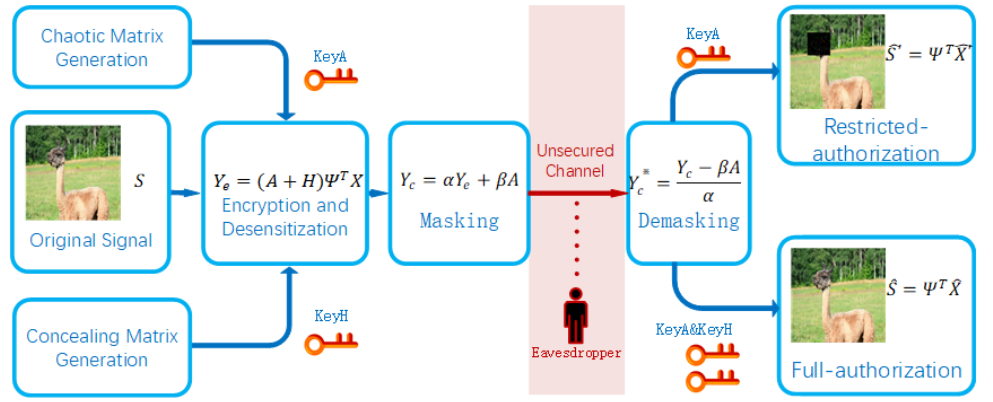
Figure 2. The main workflow of the proposed method. The left side shows the data compression, encryption, and concealing and masking processes done by a sender. The right side shows the data demasking, decryption, and retrieving processes done by receivers. The red part in the middle represents an open or insecure channel that might leak information to